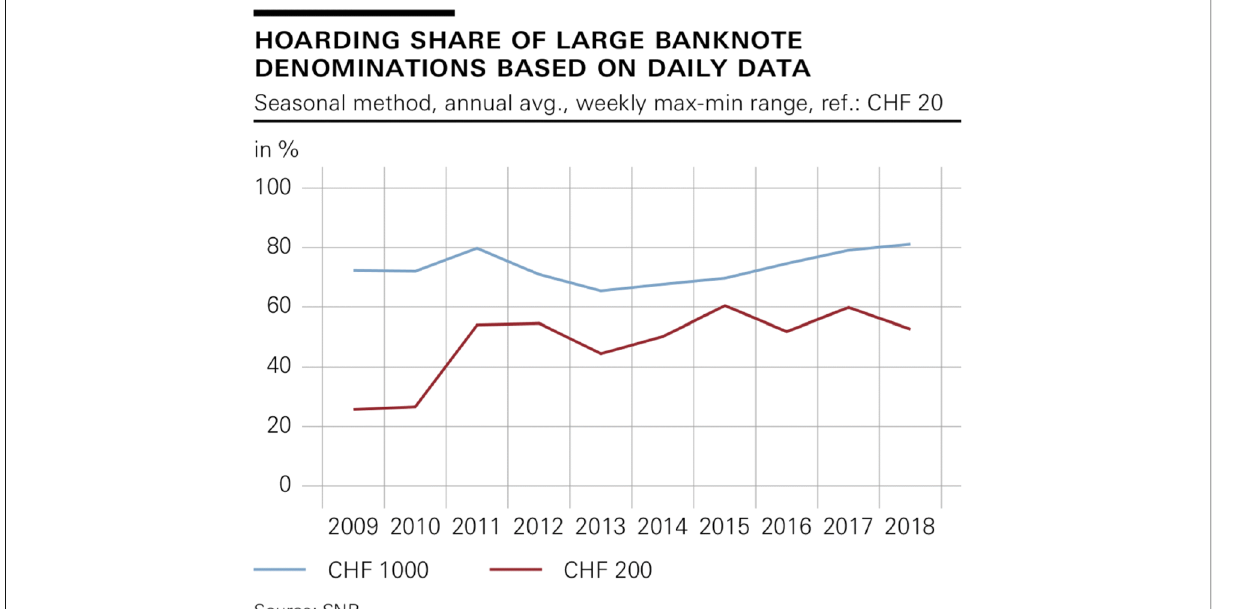
Fig. 9 Method based on seasonal patterns - results for large denominations